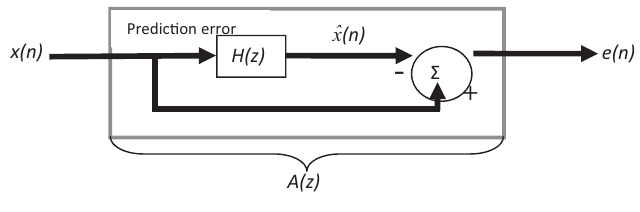
Figure 5. Prediction error fi